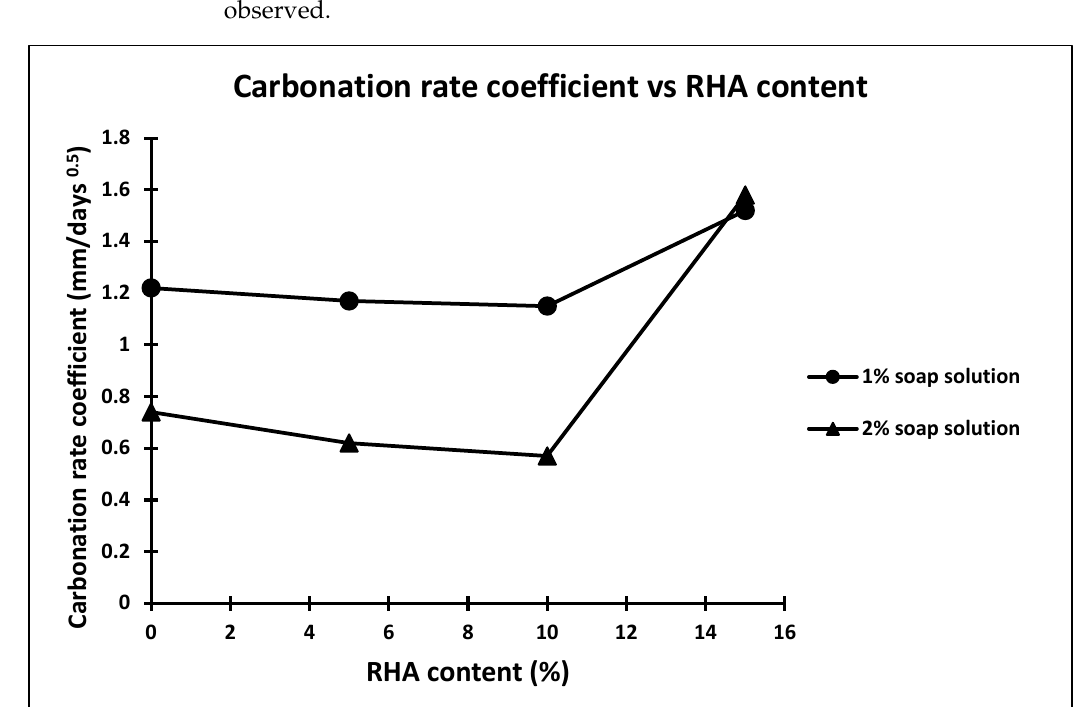
Figure 6. Carbonation rate coefficient v / s RHA.